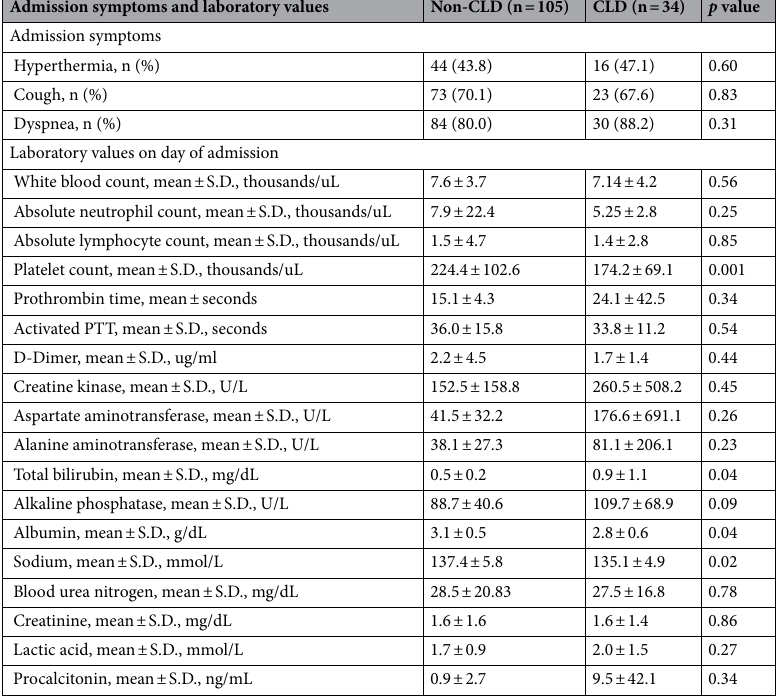
Table 2. Admission symptoms and laboratory values of admitted COVID-19 patients with or without chronic liver disease (CLD) on long-term corticosteroid treatment for co-existing